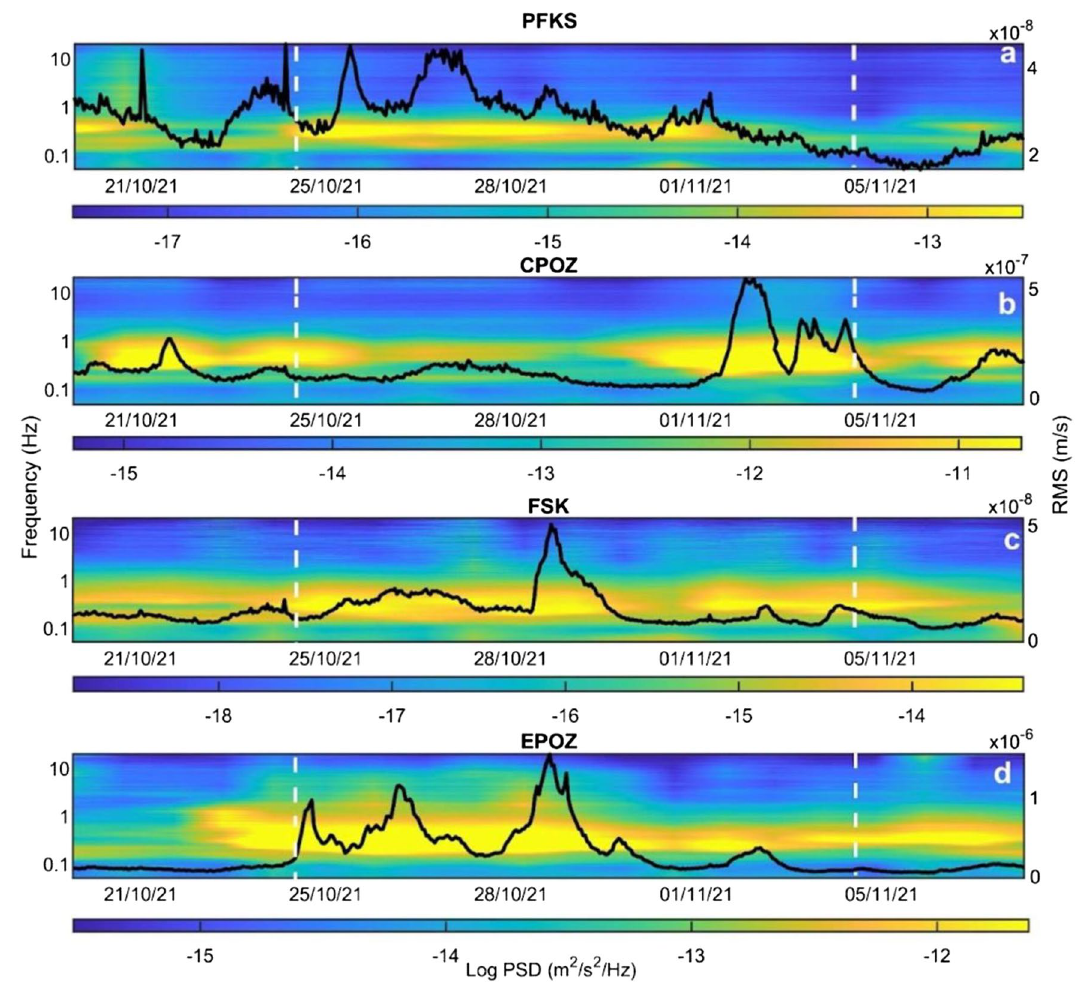
Figure 2. Spectrograms and RMS amplitude time series, for the SM band (0.1-0.2 Hz), of the seismic signal recorded by the vertical component of 4 stations located along the Greek coastline ( a , c ), in central Italy ( b ) and in the eastern part of Sicily ( d ) (see Fig. 1a for the station